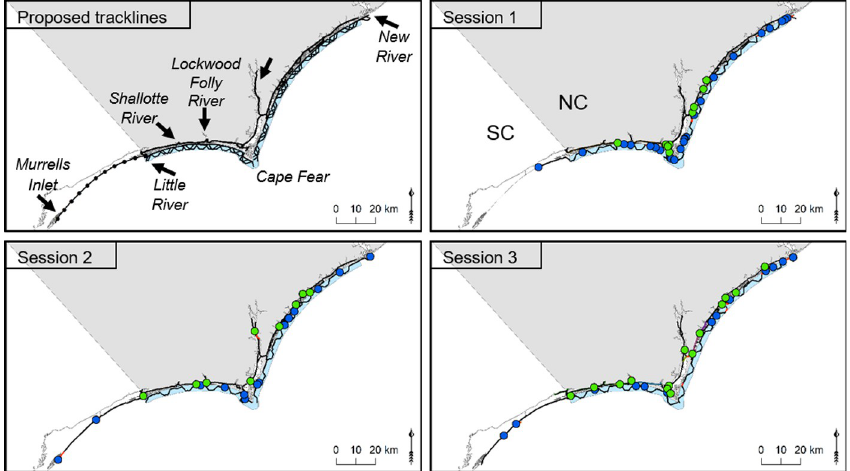
Fig 2. Survey tracklines and resulting sightings. The January 2018 capture-mark-recapture survey for abundance estimates of common bottlenose dolphins ( Tursiops truncatus ) of the designated Southern North Carolina Estuarine System Stock was designed with three photo-ID sessions. The proposed tracklines indicate the survey design, with the coastal tracklines offset so that none of the sessions had the same starting point. The actual tracklines and sightings along those tracking are shown for each of the three sessions. Habitat of sightings is indicated by color—blue circles indicate sightings on the coast and green circles indicate sightings in the